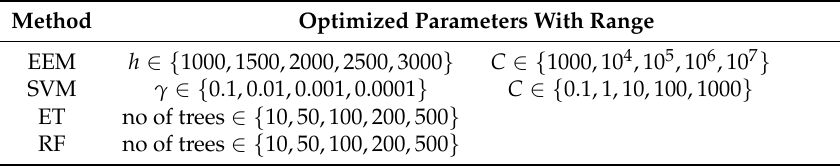
Table 2. The range of parameters tuned during the optimization of the algorithms used. C hyperparameter denotes the strength of fitting to the data, γ is the width of the RBF kernel used in Support Vector Machine (SVM), h is the number of random projections (limited also by the number of training samples; in case h exceeded the number of examples in the training set, it was reduced to the dataset size) and ‘no of trees’, referring to the number of trees, is the size of each forest.